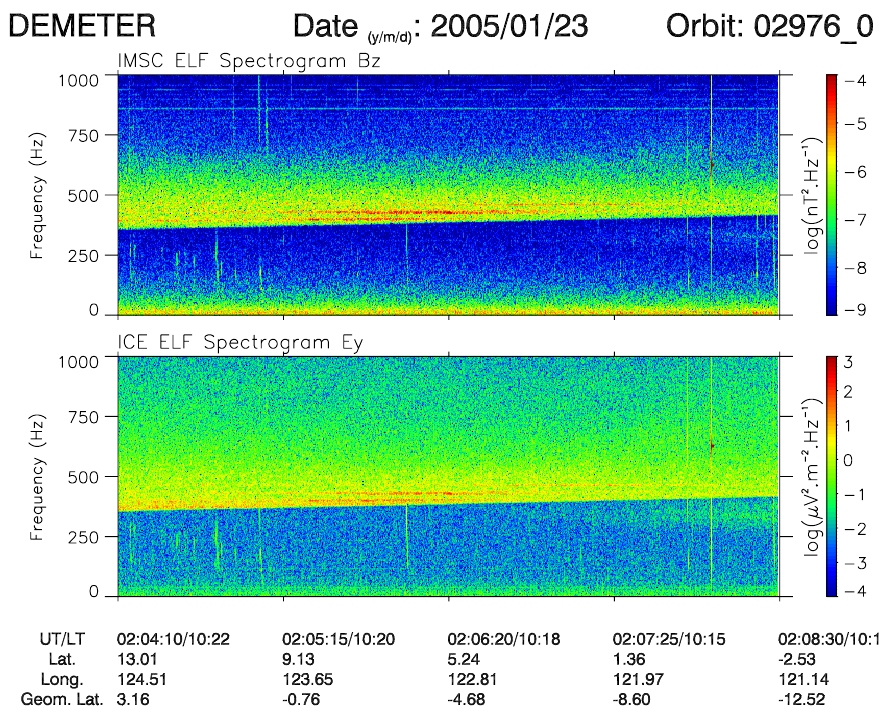
Fig. 7. Same as Fig. 1 but for the event recorded on 23 January 2005 (event 4).